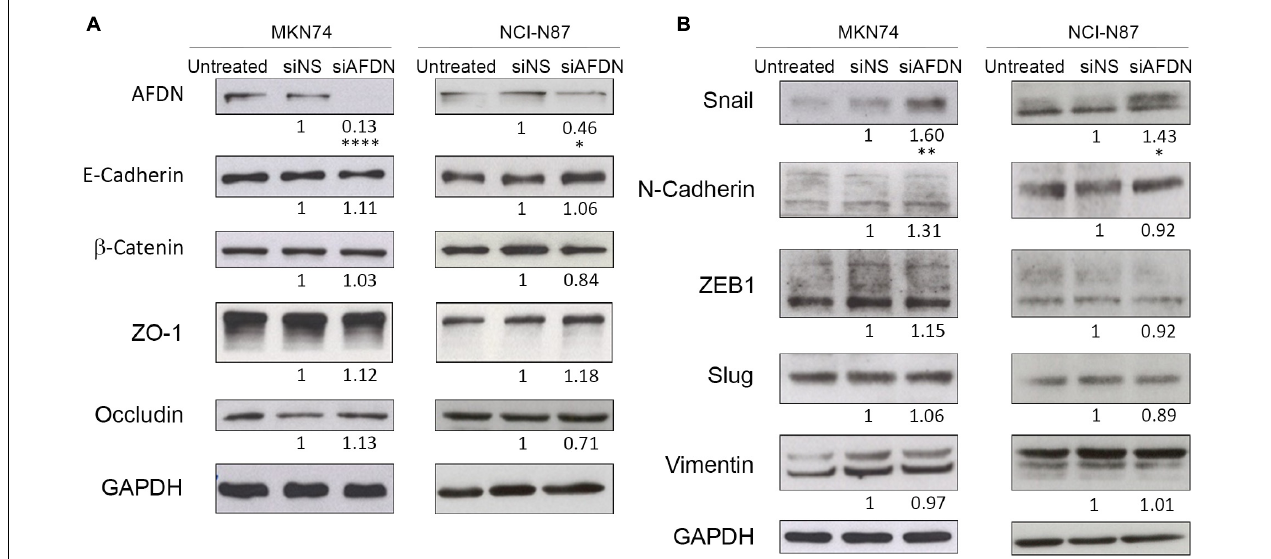
FIGURE 4 | Afadin downregulation does not alter the expression of apical junctional complex proteins, but upregulates the EMT marker Snail. Western blot analyses of MKN74 and NCI-N87 cells, cells transfected with a non-silencing siRNA (siNS), or with a siRNA to Afadin (siAFDN), evaluating (A) apical junctional complex proteins E-cadherin, β -catenin, ZO-1, and occludin, and (B) mesenchymal markers Snail, N-cadherin, ZEB1, Slug, and Vimentin. GAPDH was used as loading control. Numbers below the bands correspond to quantifications. Data are representative of three independent experiments. Statistical significance was evaluated with the Student’s t-